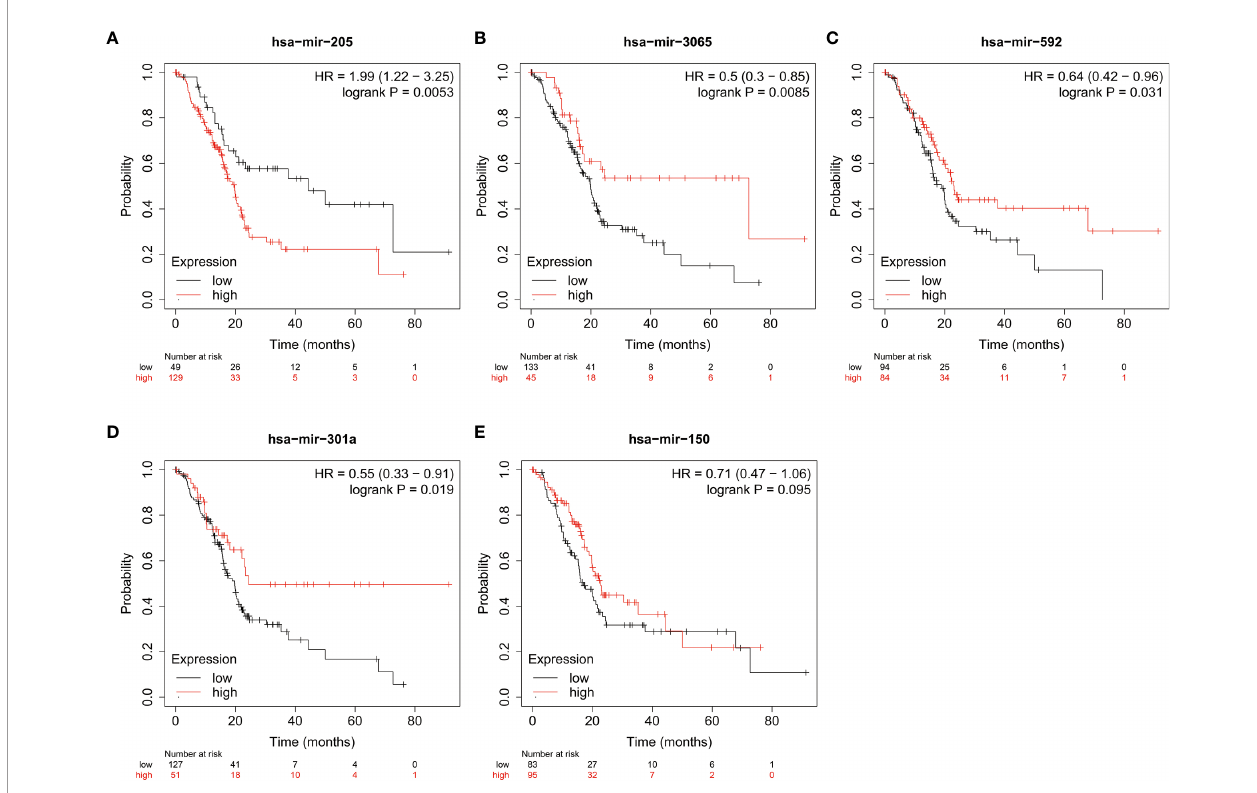
FIGURE 8 | The relationship between miRNA and prognostic survival of PAAD patients. (A – C) High expression of hsa-mir-3065 (HR=0.50, p < 0.01), hsa-mir-592 (HR=0.64, p<0.05) and hsa-mir-301a (HR=0.55, p < 0.05) is a bene fi cial factor for PAAD. (D) High expression of hsa-mir-150 was a bene fi cial factor for PAAD, although not signi fi cant (HR=0.71, 0.05<p<0.1). (E) High expression of hsa-mir-205 is a high risk factor for PAAD (HR=1.99, p <